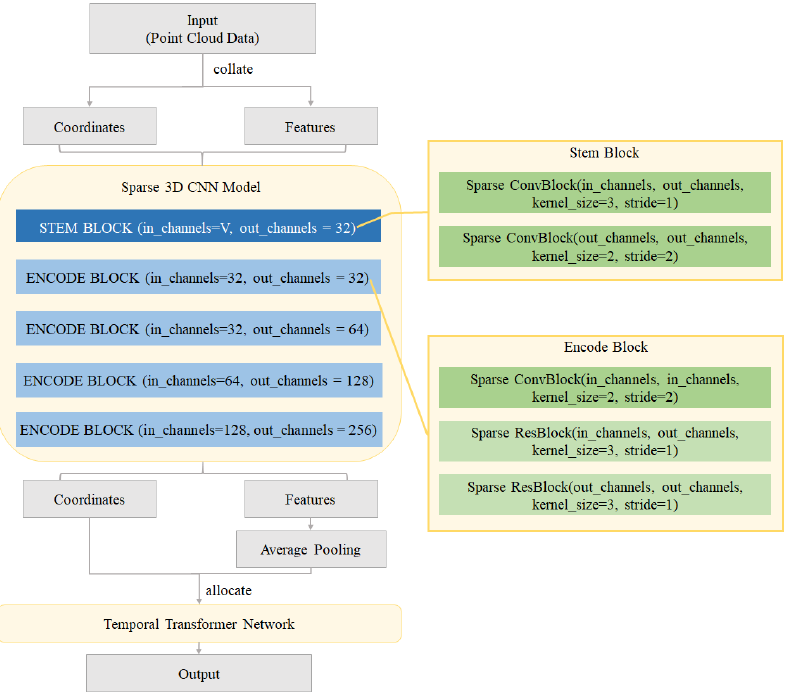
Figure 4. Details of the proposed SC3D-based model.